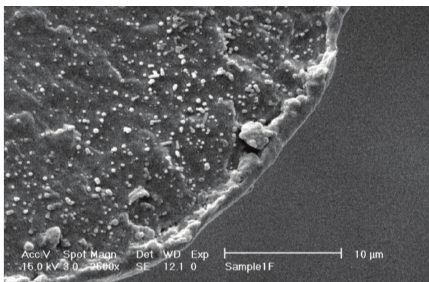
Figure 3: SEM micrograph of B12 blend fiber, magnification: ×